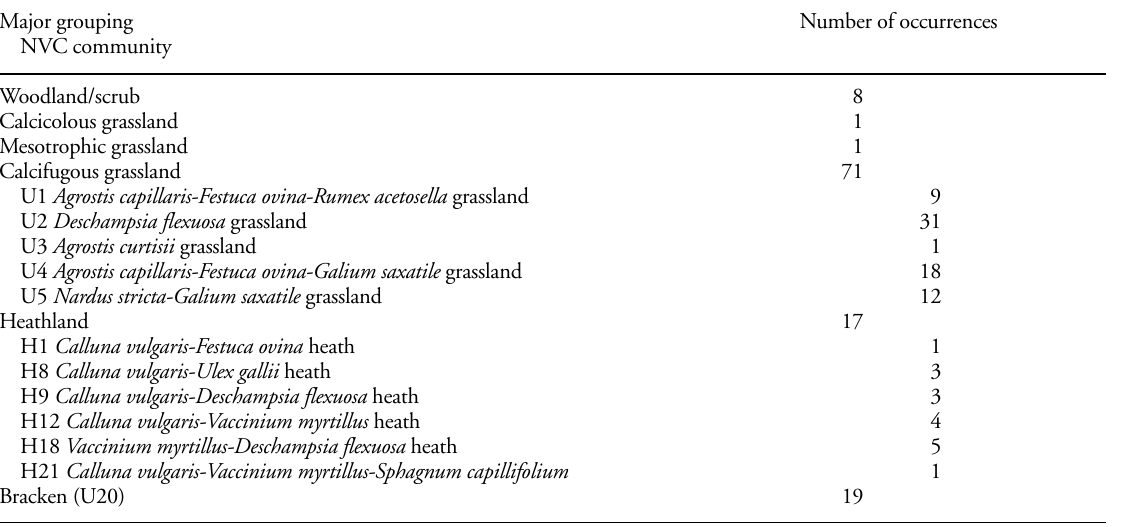
Table 1. Vegetation types (major groups and communities) of the National Vegetation Classification (Rodwell 1991a, b, 1992) that were present on the 117 sites surveyed during the national assessment of bracken control by aerial spraying.